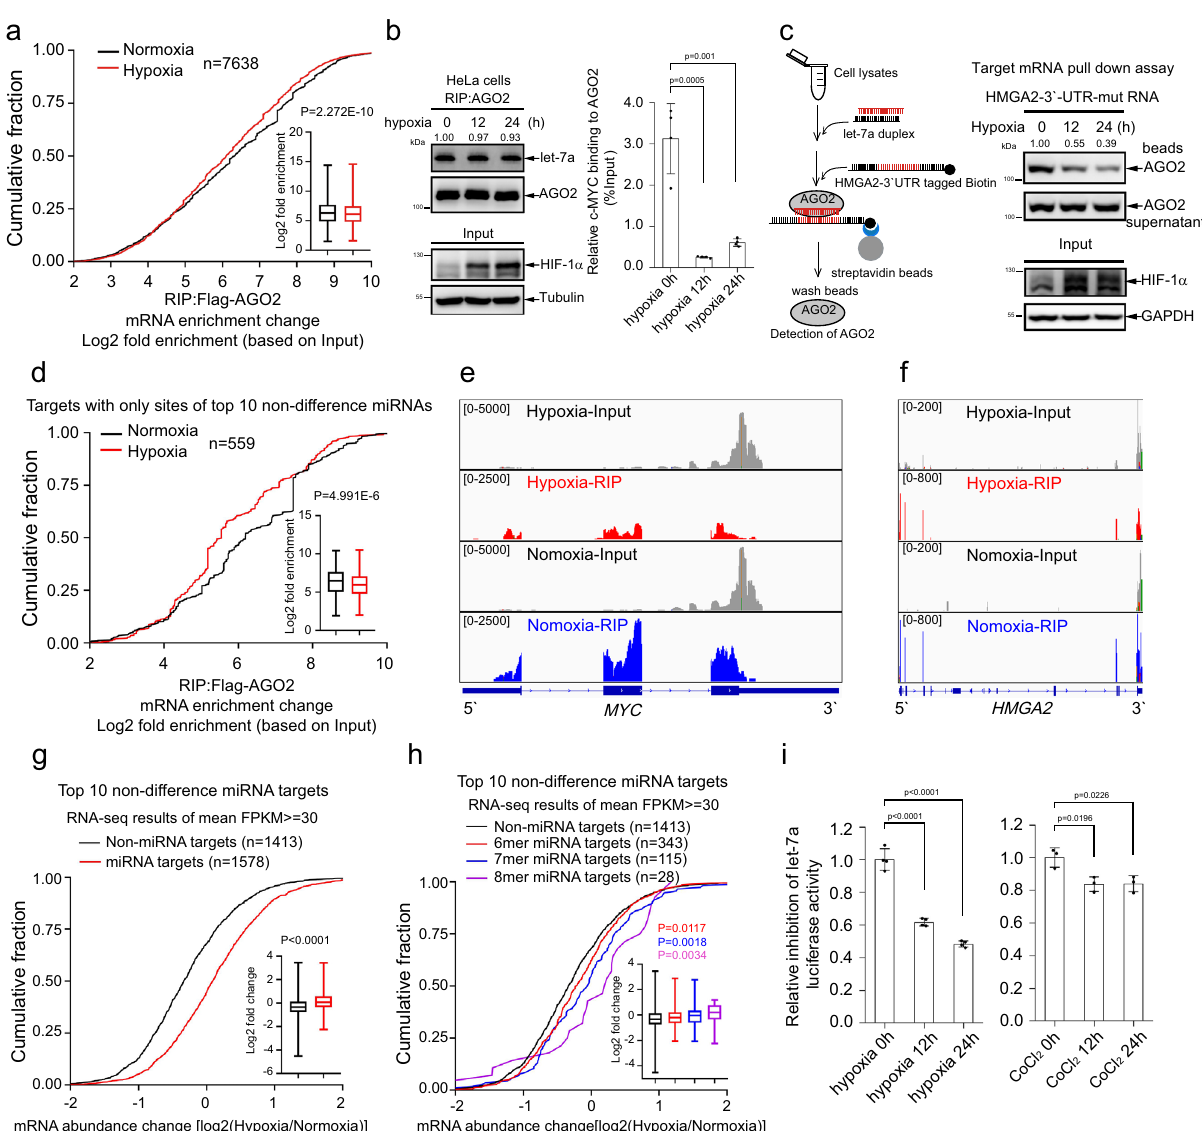
Fig. 1 Hypoxia impairs miRNA-targeted mRNA loading to AGO2 and inhibits mRNA decay. a Hypoxia inhibited mRNA loading to AGO2. Cumulative fraction analysis of RIP-Seq for mRNA transcripts bound to AGO2 ( n = 7638 mRNA transcripts) in stable HeLa cells expressing Flag-AGO2 under hypoxia (1% O 2 ) for 24 h. b , c Hypoxia suppressed the interaction of let-7a-targeted c-MYC and HMGA2 -3 ′ -UTR-mut with AGO2. b HeLa cells treated with hypoxia were performed by RIP assay, let-7a and c-MYC associated with AGO2 were detected by northern blotting and qRT-PCR, respectively. Data were mean ± s.d., n = 4 biologically independent samples, and P -values were determined by unpaired two-sided t-test. c Cell lysates from 293 T cells treated with hypoxia were co-incubated with let-7a duplex mimics and biotin-tagged HMGA2 -3 ′ -UTR-mut for in vitro targeted mRNA pull-down assay. AGO2 associated with HMGA2 -3 ′ -UTR-mut was pulled down by streptavidin beads, and then detected by WB. d – f Hypoxia decreased the interaction of AGO2 with mRNAs targeted by only top 10 non-difference miRNAs. Cumulative fraction analysis of AGO2 bound mRNA transcripts ( n = 559 mRNA transcripts) targeted by only top 10 non-difference miRNAs but not by hypoxia-reduced miRNAs in stable HeLa cells expressing Flag-AGO2 under hypoxia ( d ). Coverage plots showing the abundance of MYC ( e ) and HMGA2 ( f ) mRNAs binding to AGO2 by RIP-Seq. g , h Hypoxia increased the accumulation of mRNA transcripts targeted by top 10 non-difference miRNAs ( g ) and their corresponding 6mer, 7mer and 8mer seed sequences with a single site ( h ). Cumulative fraction analyses were performed with RNA-Seq data in HeLa-Flag-AGO2 stable cell lines under normoxia and hypoxia. i Hypoxia inhibited the let-7a-miRISC activity. 293T cells were transfected psiCHECK2-4xlet-7a-BS and then treated with hypoxia or CoCl 2 (300 μ M) for 12 and 24 h. The let-7a- miRISC activity was measured by the dual-luciferase assay. Data were mean ± s.e.m., n = 4 (left panel) or n = 3 (right panel) biologically independent experiments, and P -values were determined by unpaired two-sided t-test. In box plots, the lines represent the median, fi rst and third quartiles, the whiskers denote the minima and maxima; P -values were calculated using a two-sided Mann – Whitney U test for cumulative fraction analysis ( a , d , g , h ). fl uorescent protein (GFP) reporter as the let-7a target, in which had little role in regulating let-7a loading to AGO2 in HeLa (Fig. 1b), 293T (Supplementary Fig. 2b) and H1299 cell lines four-repeated let-7a binding site sequences were rebuilt into the (Supplementary Fig. 2c). However, the mRNA of c-MYC , targeted 3 ′ -untranslated region (3 ′ -UTR) of GFP (called GFP-4xlet-7a-BS) by let-7a, binding to AGO2 was decreased under hypoxia stress (Supplementary Fig. 2d), and stably expressed this reporter in (Fig. 1b; Supplementary Fig. 2b). We reconstructed a green 293T cells, the RIP-qRT-PCR assay showed that hypoxia